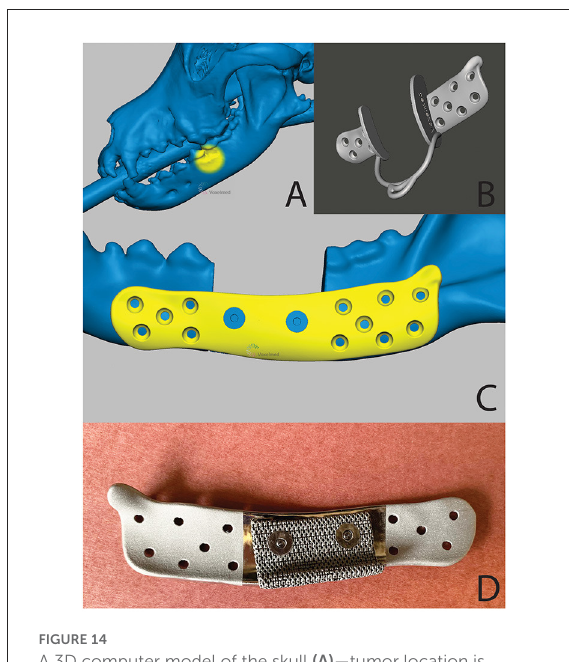
FIGURE14 A 3D computer model of the skull (A) —tumor location is highlighted in yellow), the patient-specific surgical saw guide (B) and patient-specific implant (C) —the countersunk screws to attach mesh structure are highlighted in blue) of the patient in case 1. (D) is a pre-operative photograph of the patient-specific implant from the medial aspect. Reprinted from Thatcher GP, Soukup JW. Virtual surgical planning and 3D printing in veterinary dentistry and oromaxillofacial surgery. Vet Clin North Am Small Anim Pract. 2022; 52(1):221–234 with permission from Elsevier.